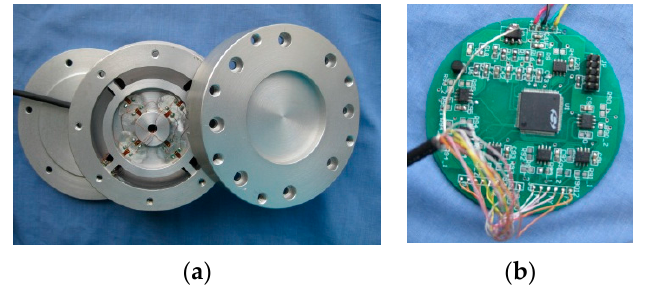
Figure 11. Prototype of the sensor system for cutting force measurement: ( a ) the upper adapter, EE and the lower adapters; ( b ) the integrated electric circuit.